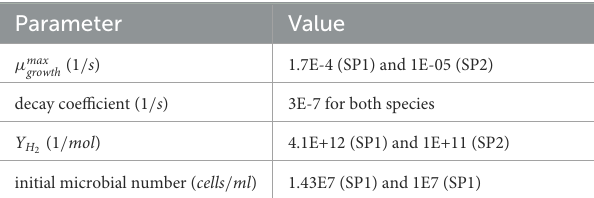
TABLE 3 Matched parameters for the first two